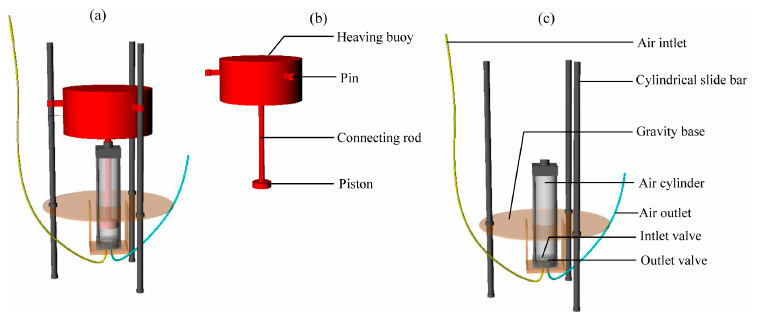
Figure 1. Device sketch ( a ) Whole components; ( b ) Heaving components; ( c )